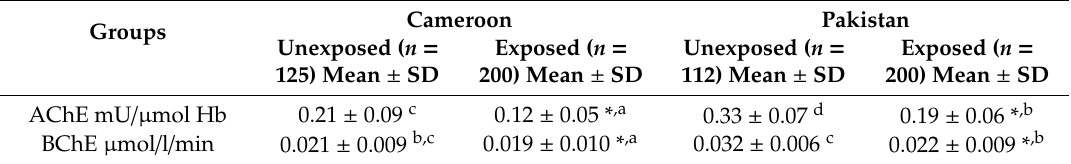
Table 2. Status of cholinergic enzymes in unexposed and OP-exposed